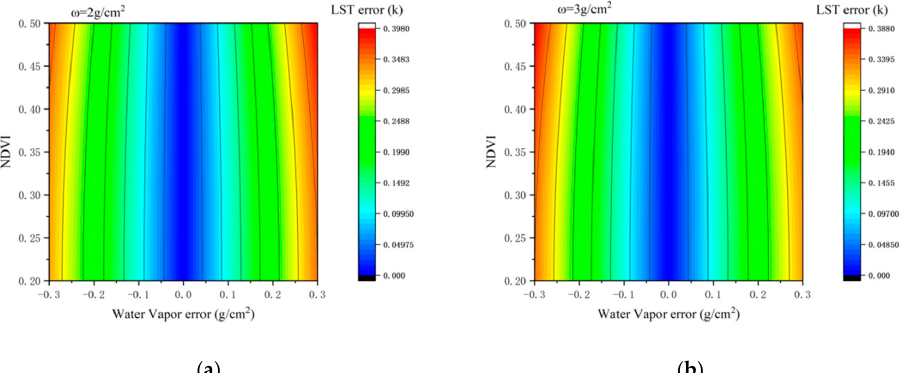
Figure 9. LST estimation error of the split window algorithm in the case of different LSE s as a result of the estimation error in water vapor content. ( a ) when the water vapor content is 2 g/cm², ( b ) when the water vapor content is 3 g/cm².